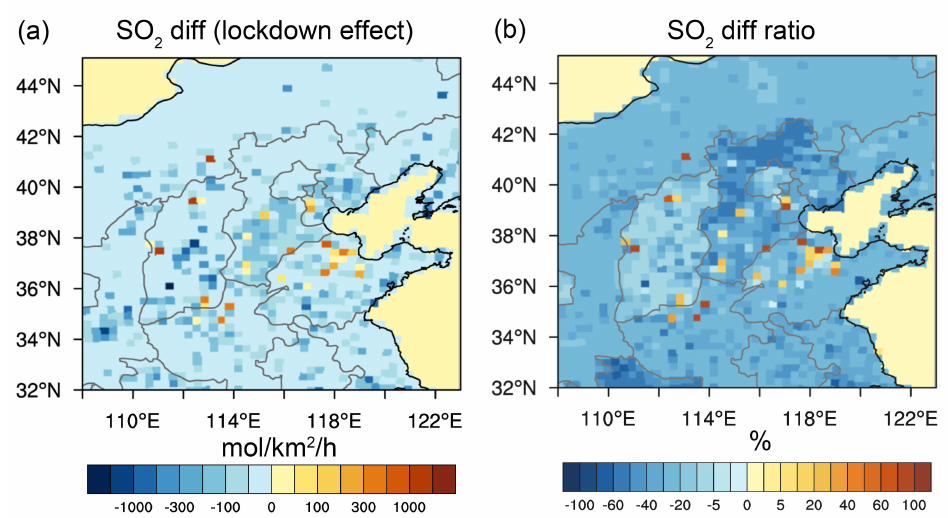
Figure 4. The differences in the SO 2 emission distribution in grids for ( a ) the lockdown effects (lockdown minus pre-lockdown optimized inventory; units: mol/km 2 /h) and ( b ) the corresponding ratios (units: %).